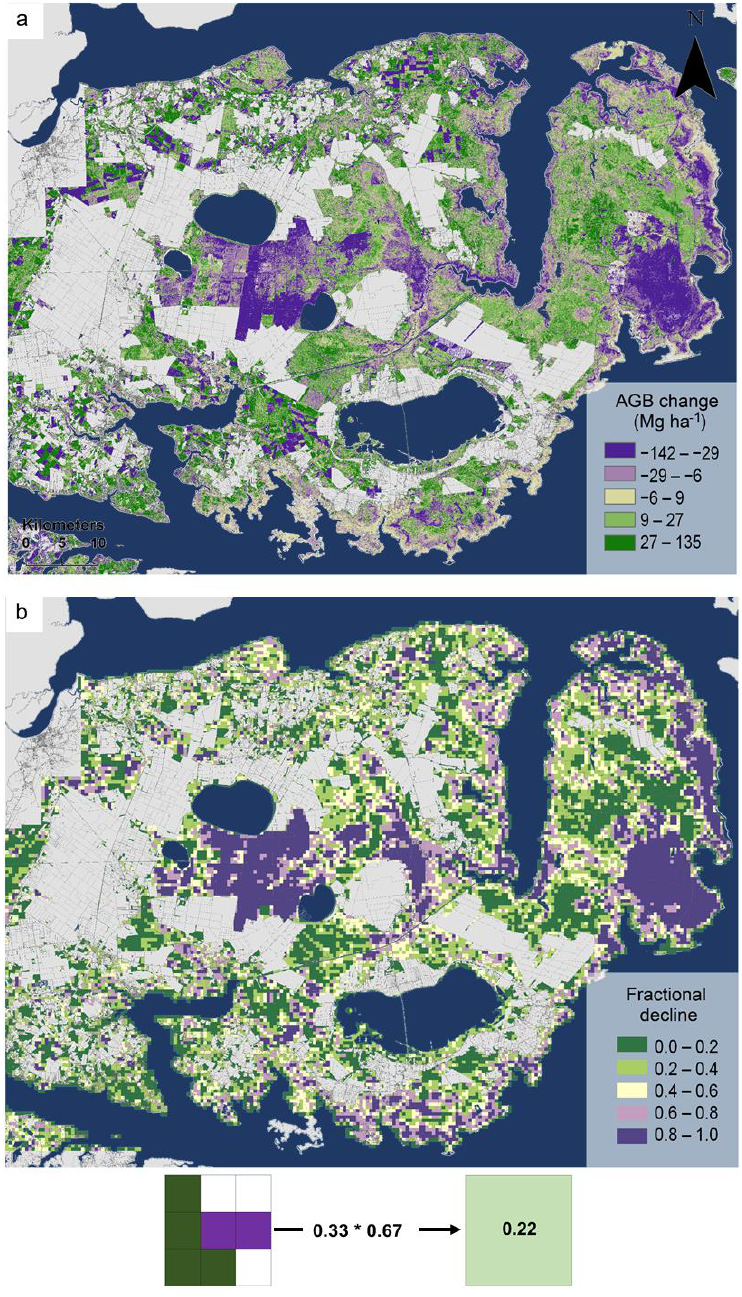
Figure 3. ( a ) Aboveground biomass change, measured as Mg ha − 1 , between 2001 and 2014, for the Albemarle-Pamlico study area in Eastern North Carolina. Areas excluded from the model are in light grey. Water bodies and the Albemarle and Pamlico Sounds are dark blue. ( b ) Fractional carbon decline, calculated from ( a ) by converting 30-m grid cells to carbon loads, developing a binary 30-m resolution map by assigning carbon declines values of 1, and aggregating data to 450 × 450-m grid. Fractional carbon decline is the fraction (see inset schematic; purple cells divided by green cells; 0.33) of the percentage of vegetation area (colored cells divided by total number of cells; 0.67) within each 450 × 450-m modeling unit experiencing decline.